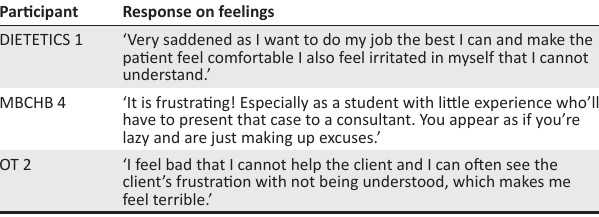
TABLE 2: Participants’ feelings related to difficulty understanding patients.